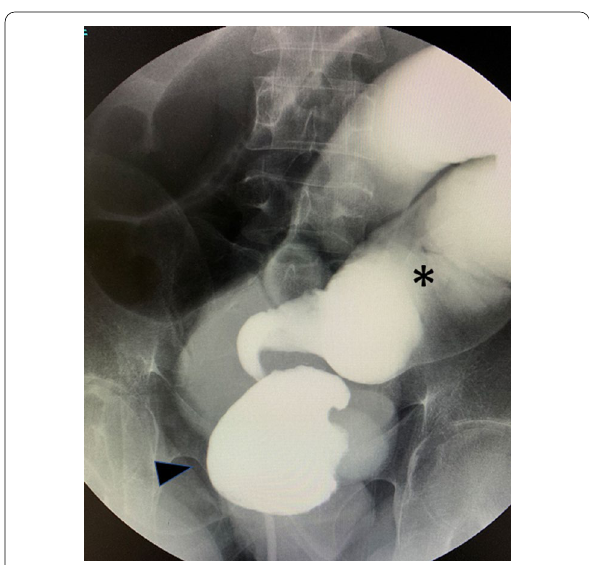
Fig. 3 Counterclockwise rotation (270°) of the afferent limb of the pouch was recognized. *: Volvulus in the afferent limb of the pouch, White up-pointing triangle: superior mesenteric artery and